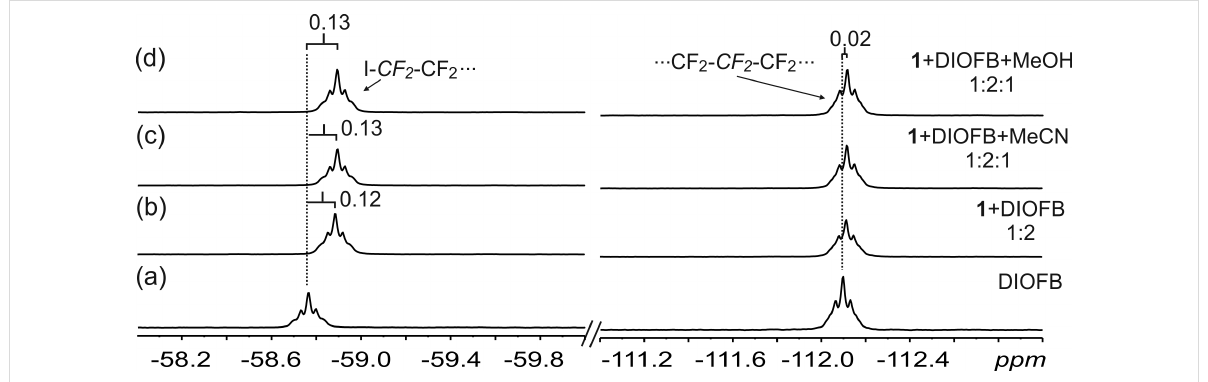
Figure 5: 19 F NMR in CDCl 3 at 298 K of: a) DIOFB (10 mM); b) 1:2 mixture of DIOFB and 1 ; 1:2:1 mixture of DIOFB, 1 , and c) MeCN, d) MeOH. The dashed lines give an indication of the signal changes in ppm, resulting from the formation of XBs. The dashed lines give an indication of the signal changes in